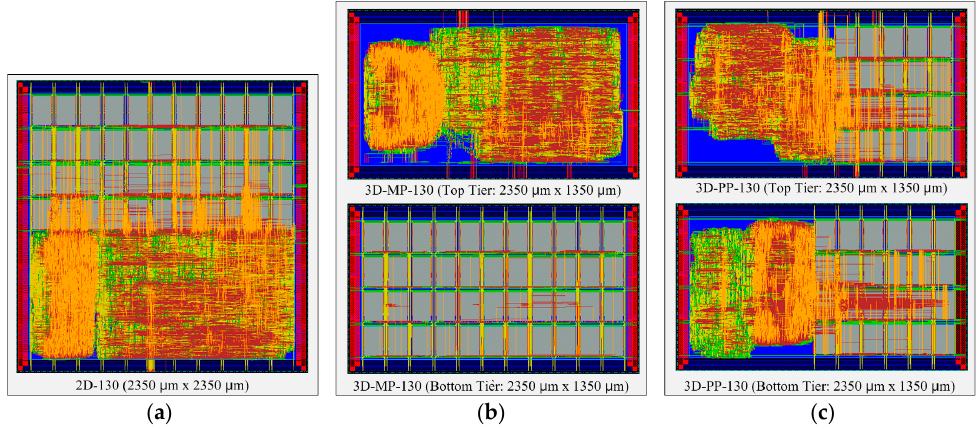
Figure 11. Layout snapshots of 2D and 3D ICs designed in 130-nm process technology: ( a ) 2D IC (2D-130); ( b ) the top and bottom tiers of a 3D IC using macro-level partitioning (3D-MP-130); and ( c ) the top and bottom tiers of a 3D IC using pipeline-level partitioning (3D-PP-130).